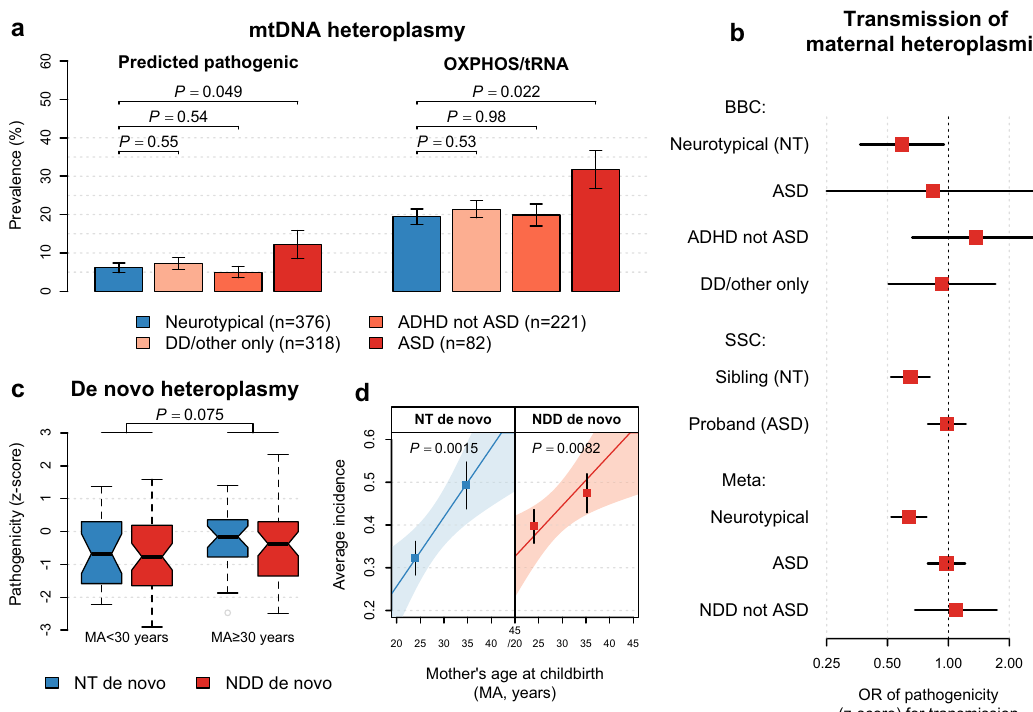
Fig. 6 Replication of fi ndings on mtDNA heteroplasmy prevalence and transmission as well as maternal age effect in the BBC. a Bar plots for the family- adjusted prevalence of predicted pathogenic (PP) heteroplasmies and heteroplasmies at nonsynonymous sites in oxidative phosphorylation genes or at all sites in tRNA genes (OXPHOS/tRNA), respectively. Error bars represent bootstrapped SEM. Two-sided P values are from logistic regression further adjusted for mtDNA content z-score. b Forest plots for the effects of per standard deviation increase in pathogenicity z-score on transmission of maternal mtDNA heteroplasmies to the child. Horizontal black lines represent the 95% con fi dence interval of the odds ratio (OR) among children indicated by the label on the y axis (from top to bottom, BBC: n = 376, 82, 221, and 318 children; SSC: n = 1938 siblings and 1938 probands; Meta: n = 2314, 2020, and 539 children). Combined effects were estimated based on a fi xed-effect meta-analysis (Meta) of the results from the SSC and BBC. Values on the x axis are shown on a logarithmic scale. c Box plots for the distribution of pathogenicity z-scores among de novo heteroplasmies (from left to right, NT: n = 24, 30; NDD: n = 52, 50) in children born to mothers aged below and above 30 years. Two-sided P values are from linear regression. All box-plot elements are de fi ned in the same way as in Fig. 1. d Maternal age-dependent increase in the number of de novo heteroplasmies. Points and error bars represent mean ± SEM among children (from left to right, NT: n = 242, 134; NDD: n = 368, 253) in the two maternal-age groups in ( c ). The P value (two-sided) and the shaded area indicate the signi fi cance of the slope and the 95% con fi dence interval of the linear regression line (the solid line), respectively. ASD: autism spectrum disorder; ADHD: attention-de fi cit/hyperactivity disorder; DD: developmental delay; NDD: neurodevelopmental disorder. Table 1 Association of predicted pathogenic heteroplasmies with ASD risk in the SSC and BBC, respectively, and in combined samples of the SSC and BBC.